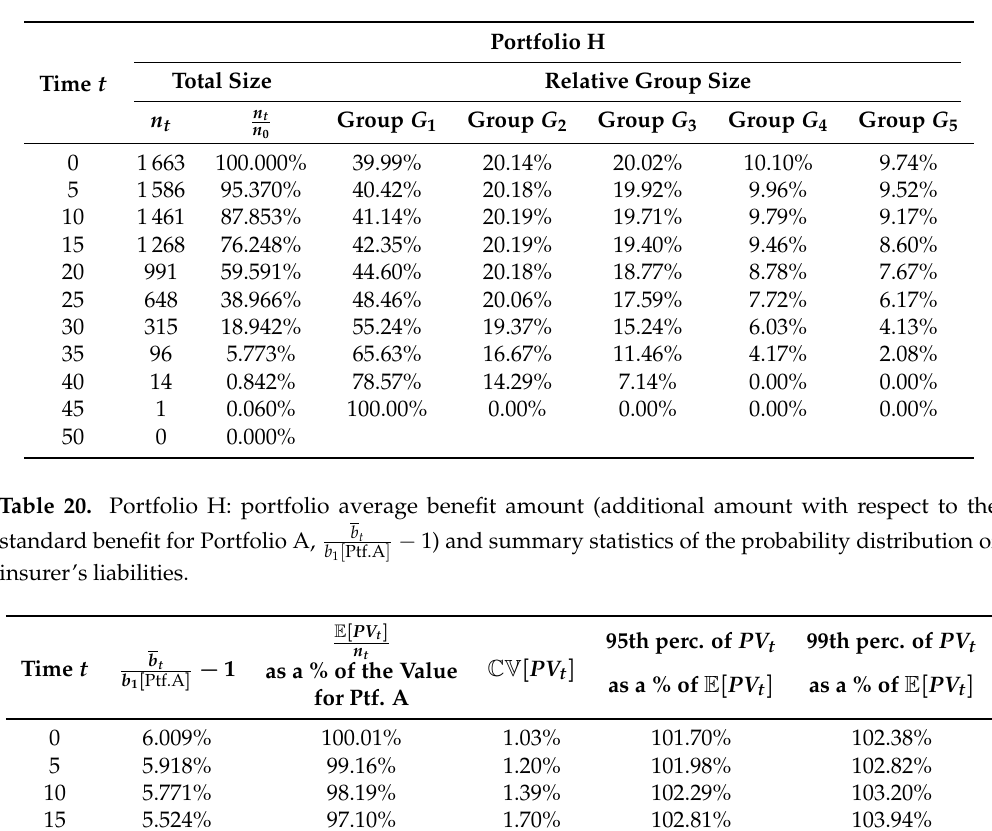
Table 19. Portfolio H: portfolio size and composition.